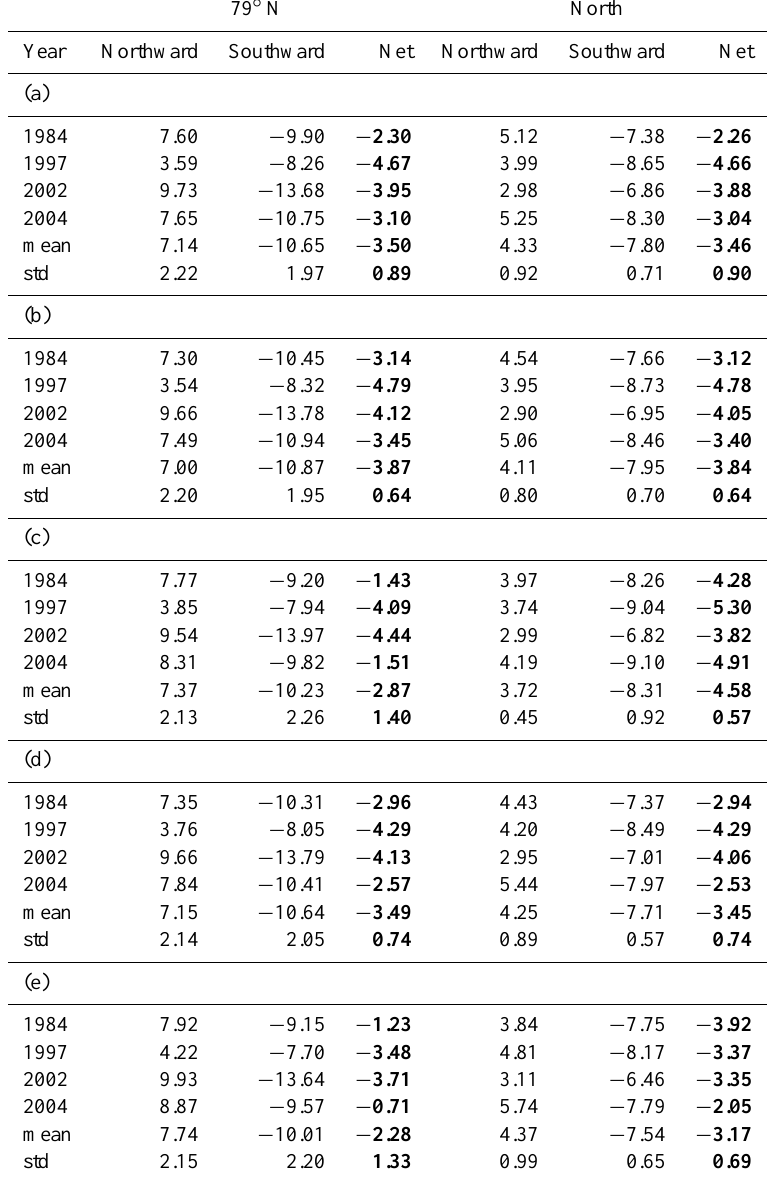
Table A1. Volume transports (Sv) as obtained from combinations of constraints. (a) constraints 1, 2, 5 and where applicable 6 are applied. (b) constraints 1, 5 and where applicable 6 are applied. (c) constraint 5 and where applicable 6 is applied. (d) constraint 1 is applied. (e) constraints 2 and 3 are